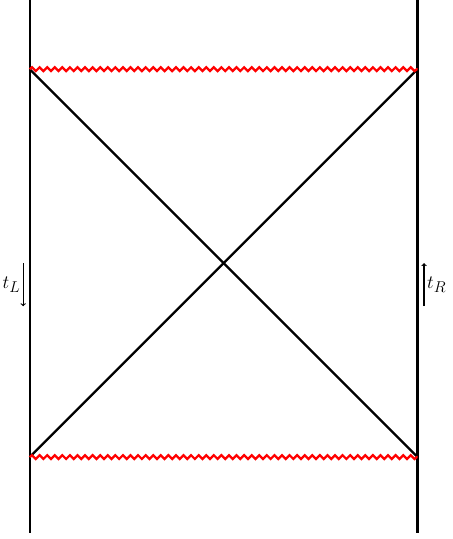
Figure 1 . We draw the Penrose diagram for the AdS 2 black hole with b = 1 in ( (cid:28); (cid:22) ) space where the wiggly red lines represent the location of